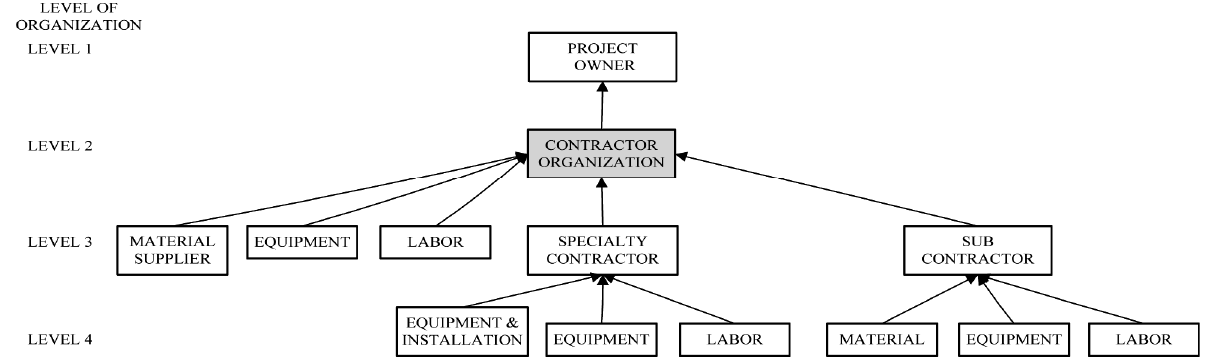
Fig. 1. General pattern of construction supply chains (Susilawati